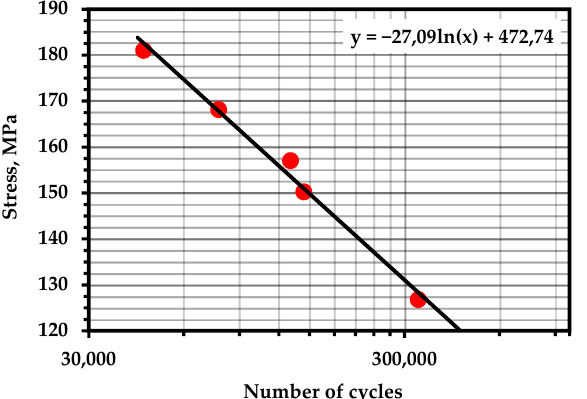
Figure A18. S–N Curve—GJS-400-15 (Temperature—293 К ; frequency—20 Hz) [109].